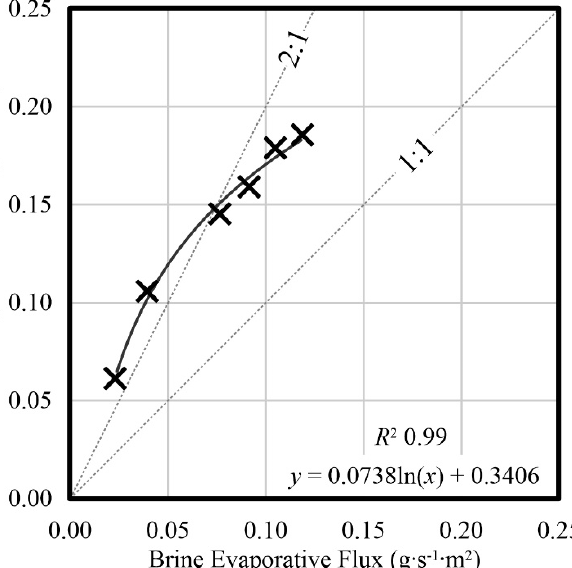
Figure 3. Measured evaporative flux correlation between distilled water and saturated brine sur- faces.